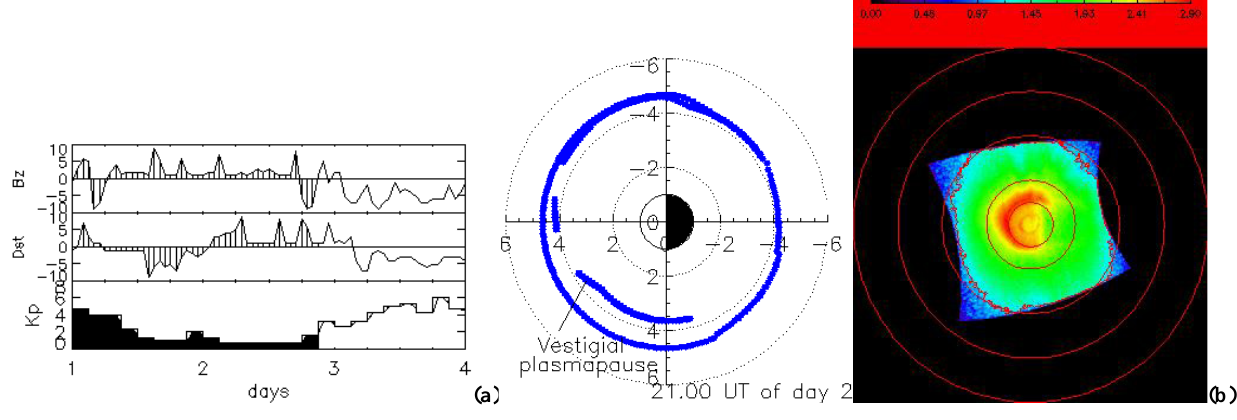
Fig. 8: Same as Fig. 1 for June 25, 2000, 21h00 (left panel (a), simulation) and 21h03 UT